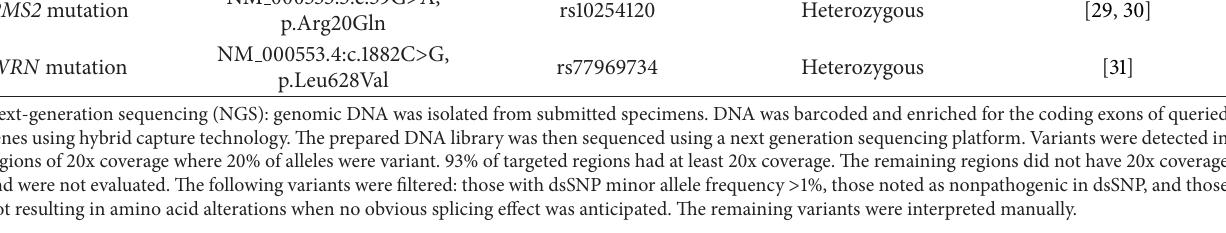
Table 3: Gene sequencing results for the Asian patient. Mutation information is provided accordingly. Genomic profiling